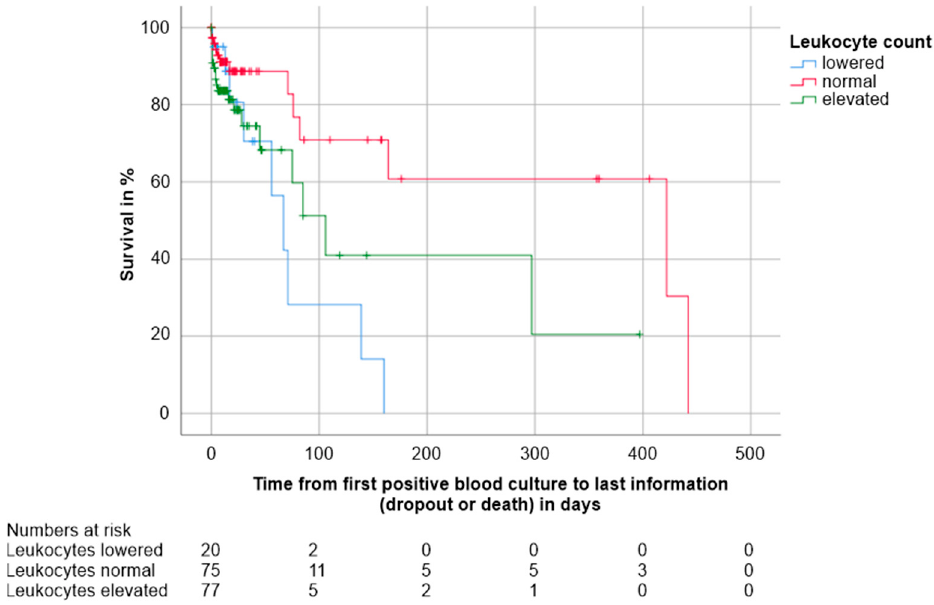
Figure 7. Kaplan-Meier survival estimates distinguished by leukocyte count: lowered, i.e., <3.9 × 10³/µL ( n = 20, 9 deaths); normal, i.e., 3.9–10.9 x10³/µL ( n = 75, 13 deaths); and elevated, i.e., >10.9 × 10³/µL ( n = 77, 20 deaths). The numbers of patients under observation per leukocyte group at each time point are given below the figure. Survival was worse in patients with elevated or lowered leukocyte counts compared to those with normal values ( p = 0.029 and p = 0.003, respectively). Data of six patients were missing.